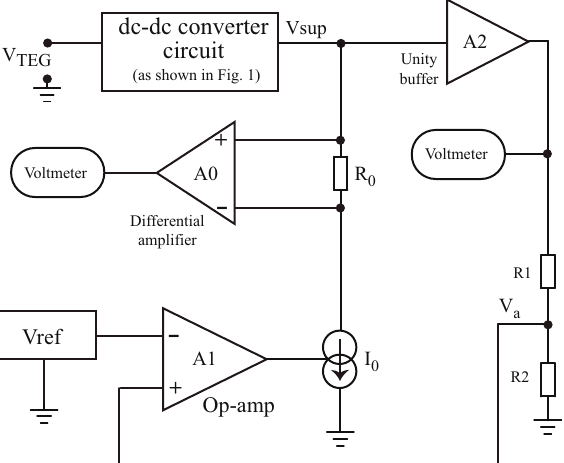
Figure 4. Block diagram of the measurement circuit that performs also as an electronic load circuit.